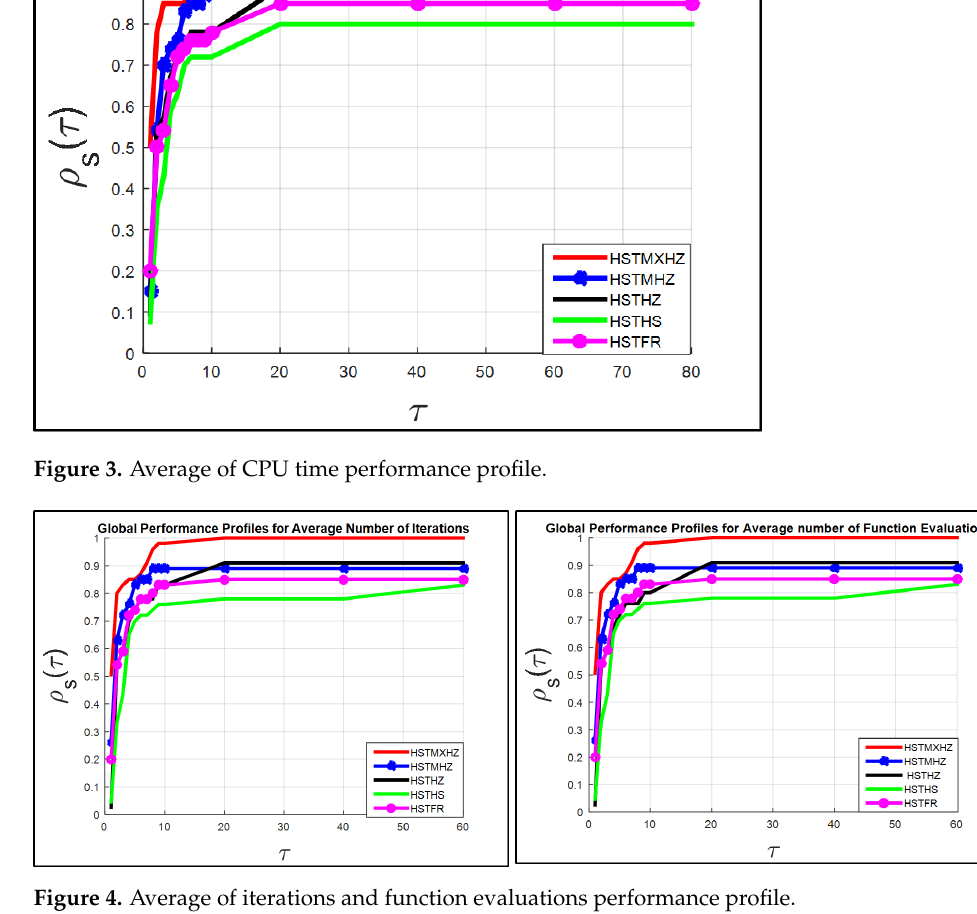
Figure 4. Average of iterations and function evaluations performance